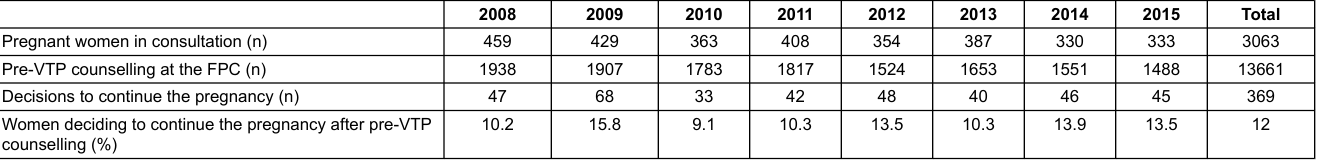
Table 6: Women deciding to continue the pregnancy after pre-VTP counselling at the